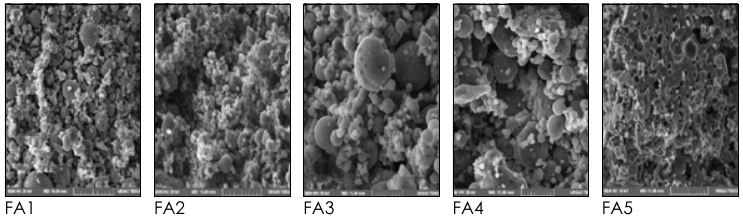
Figure 7: Morphology of the studied bricks from SEM